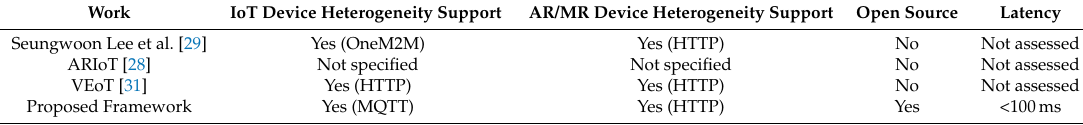
Table 1. Comparison of the challenges addressed by the most relevant AR/MR-IoT frameworks.